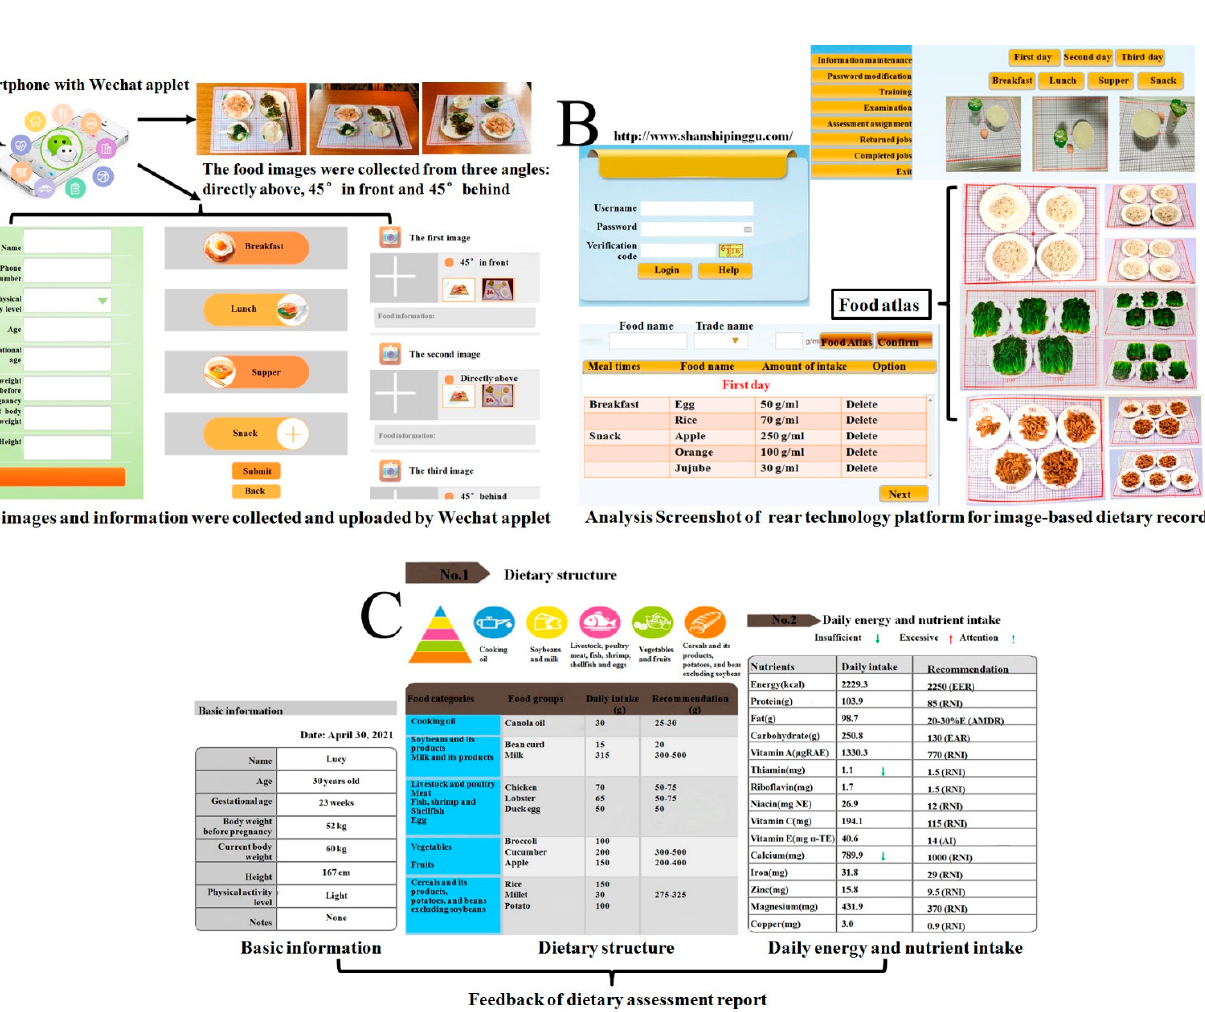
Figure 1. Overview of the WeChat Applet for Image-based Dietary Assessment (WAIDA). To collect meal information, images are taken from three angles using the built-in smartphone camera and uploaded through the WeChat Applet to a web server ( A ). Analysis consists of the dietary assessor identifying and quantifying the food in each image. The food atlas is used to assist in food quantification ( B ). Dietary data is entered directly into the database to obtain the intake of each food category and estimate the energy and nutrient intake. The basic information of pregnant women, the rationality of dietary structure, and the daily intake of energy and nutrients are then fed back ( C ).